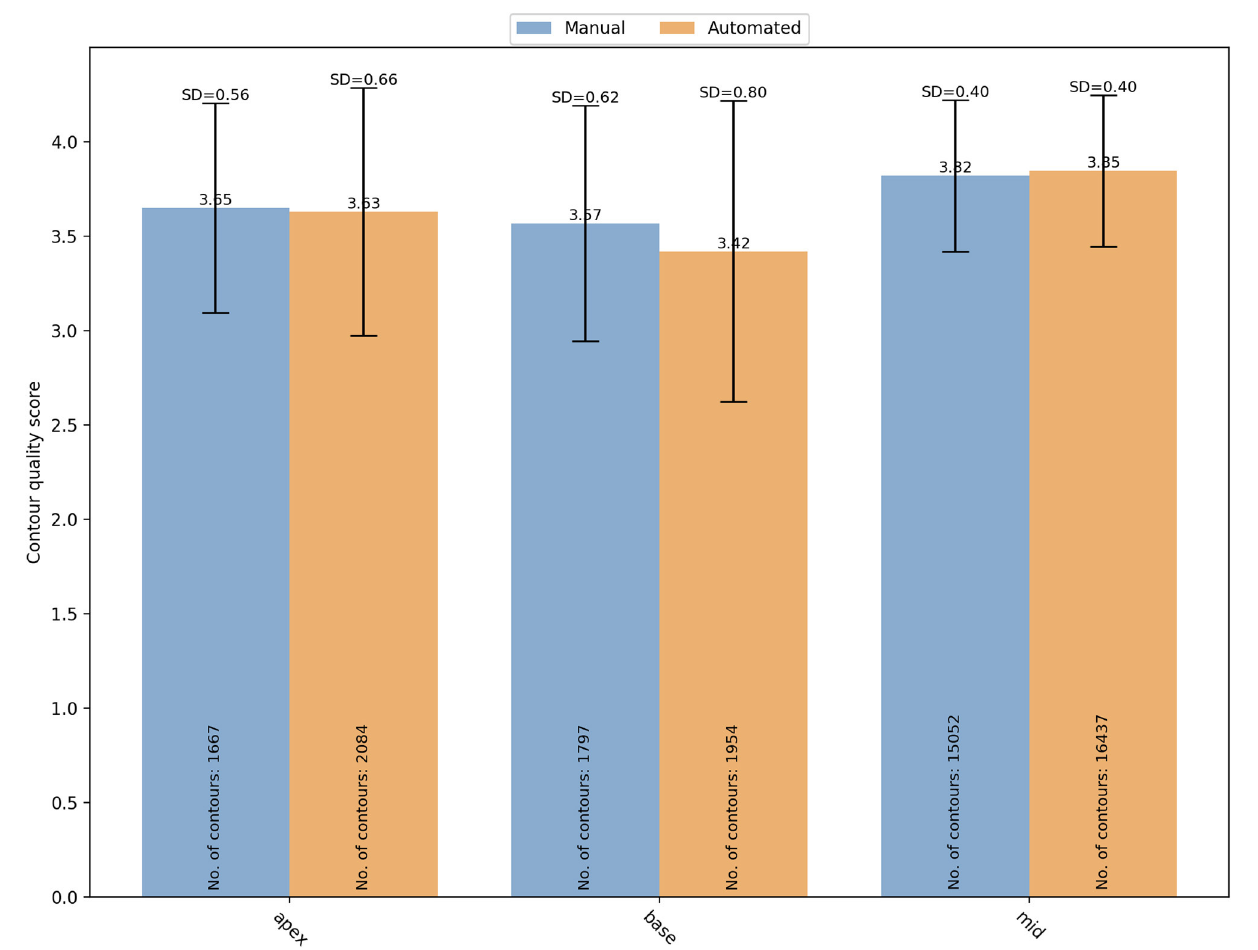
FIGURE 6 | Distribution of the overall mean quality scores for different SAX slice levels (apical, basal and mid) with manual (blue) and automated (orange) segmentation. SD, standard deviation.